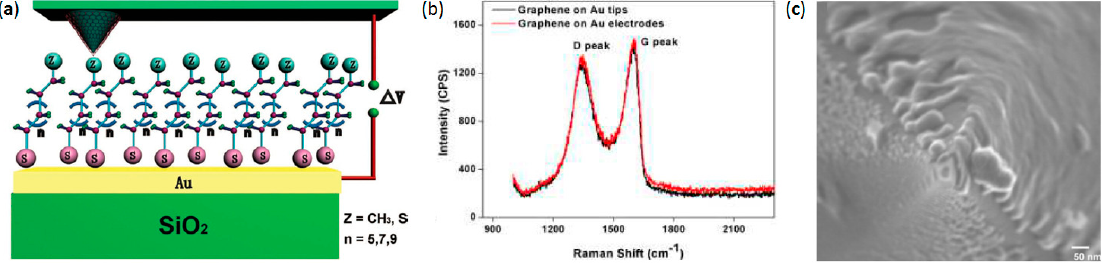
Figure 1. Direct chemical vapor deposition of graphene on metal-varnished AFM tips. ( a ) Schematic representation of an Au-varnished AFM tip coated with graphene that is being used as top electrode in a molecular junction; ( b ) Raman spectrum of the graphene formed on the Au electrode (red) and Au-coated AFM tip (black line); ( c ) SEM image of the tip apex after the CVD process. The surface appears to be covered by a discontinuous and thick layer, rather than atomically-thin continuous graphene. Reproduced with permission from [23], copyright Wiley-VCH (2012).